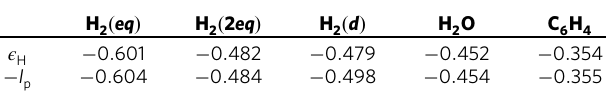
Table 1 Comparison of the highest occupied Kohn – Sham eigenvalue ( ϵ ) and the negative of the ionization potential H ( I ) (all in Ha) p